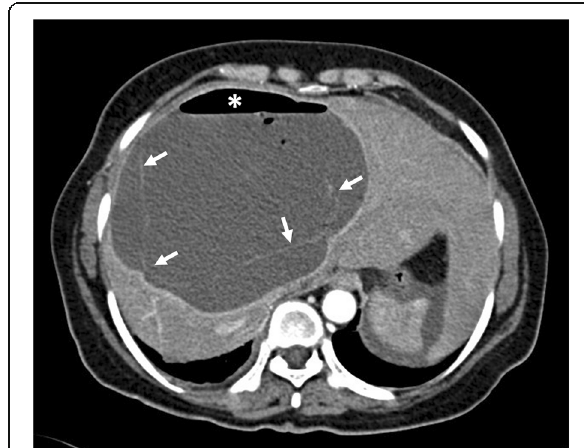
Fig. 3 A 62-year-old woman presented to the emergency department with fever, fatigue, and right upper quadrant pain. The patient had a previous history of liver hydatid disease which was stable for 1-year of follow-up. Axial contrast-enhanced CT image shows a liver abscess. Floating membranes (arrows) and associated air-fluid level (asterisk) within the cyst indicating superinfection of a liver hydatid cyst. Culture test following percutaneous drainage of